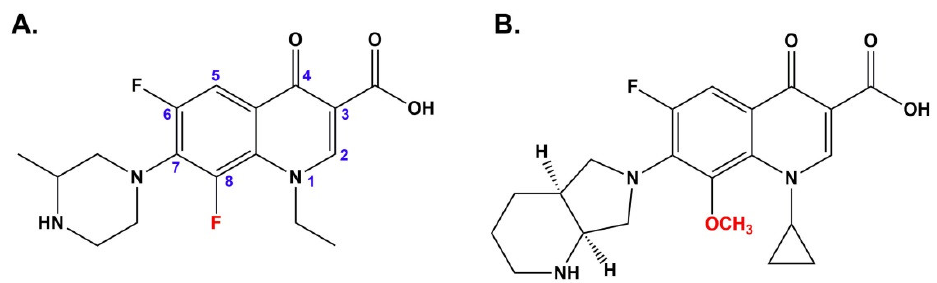
Figure 1. Chemical structures of lomefloxacin ( A ) and moxifloxacin ( B ). Cutaneous side effects of FQs may result from their accumulation in skin cells. Pre- viously, we showed that lomefloxacin, ciprofloxacin, sparfloxacin, norfloxacin, and moxi- floxacin bound to melanin biopolymer [19,20]. FQ-derivatives differ in a number of bind- ing sites on melanin that may lead to differences in pharmacokinetics and skin toxicity between drugs of this antibiotic class. Among others, the least phototoxic moxifloxacin is characterized by the lowest number of binding sites on melanin.